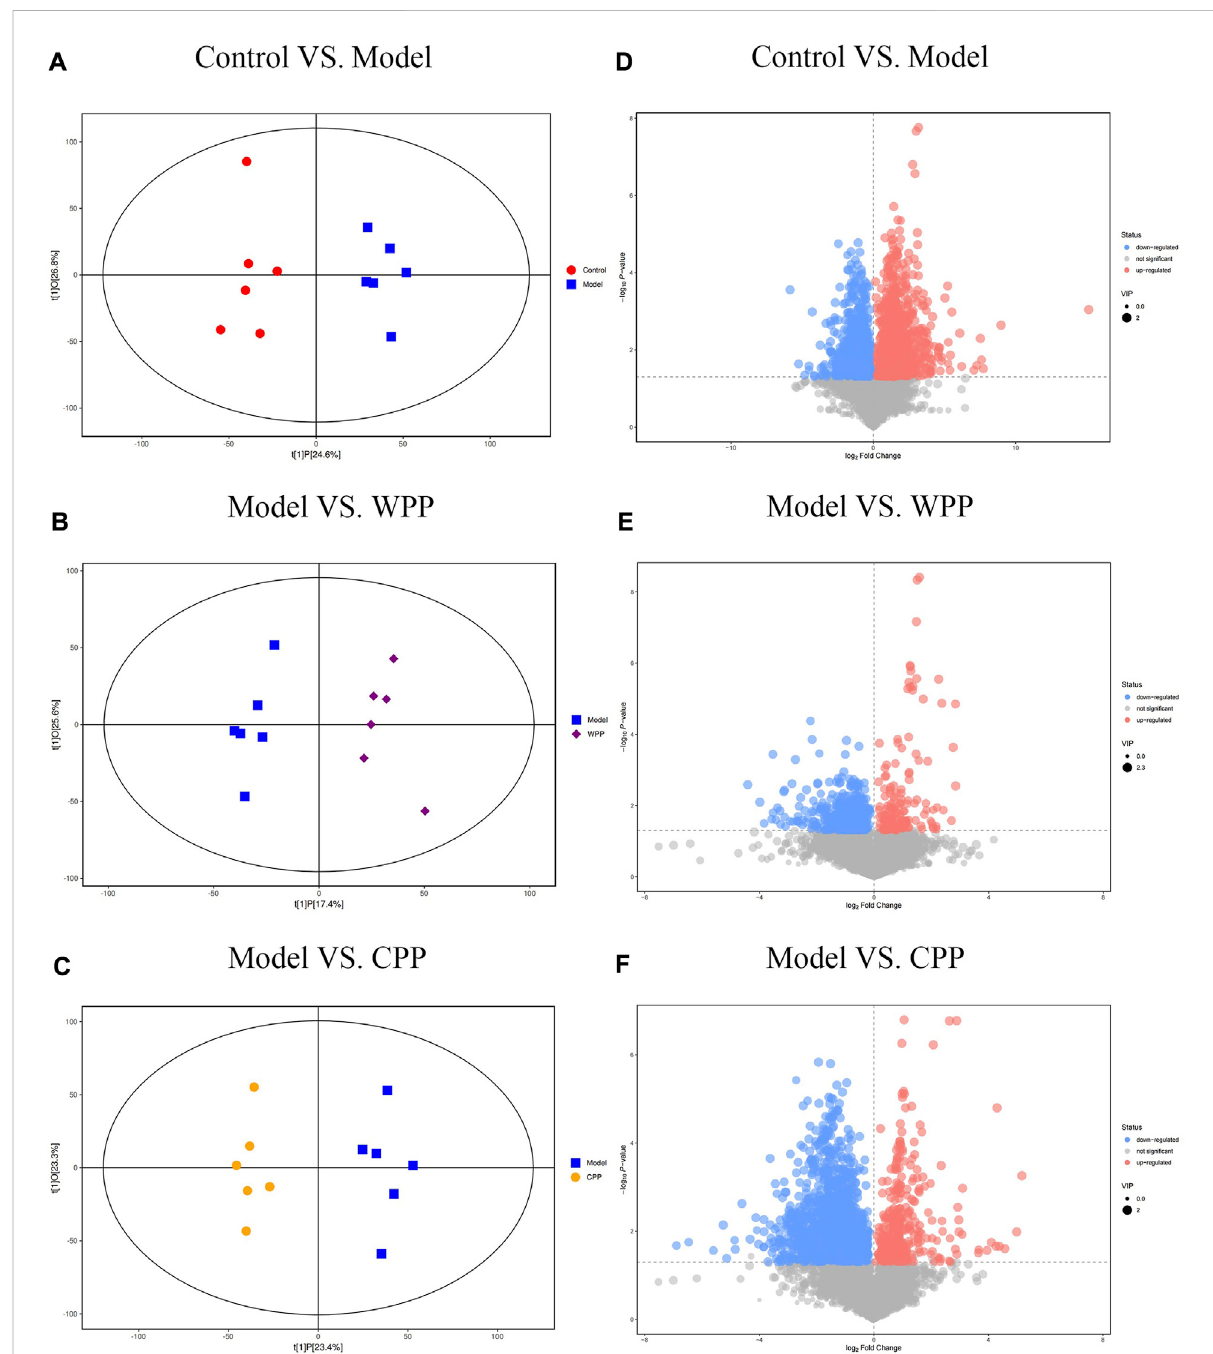
FIGURE 7 Orthogonal projections for the latent structures-discriminate analysis (OPLS-DA) score plot and volcano plot between the control group, model group, WPP-treated group (40 μ g/ml), and CPP-treated group (40 μ g/ml) in the positive ion mode (POS) (n = 6). OPLS-DA score plots between the control group and model group (A) , model group and WPP-treated group (40 μ g/ml) (B) , and model group and CPP-treated group (40 μ g/ml) (C) . The volcano plots between the control group and model group (D) , model group and WPP-treated group (40 μ g/ml) (E) , and model group and CPP-treated group (40 μ g/ml) (F) are also shown above. The X -axis and Y -axis represent the log2-fold change and − log 10 p value,